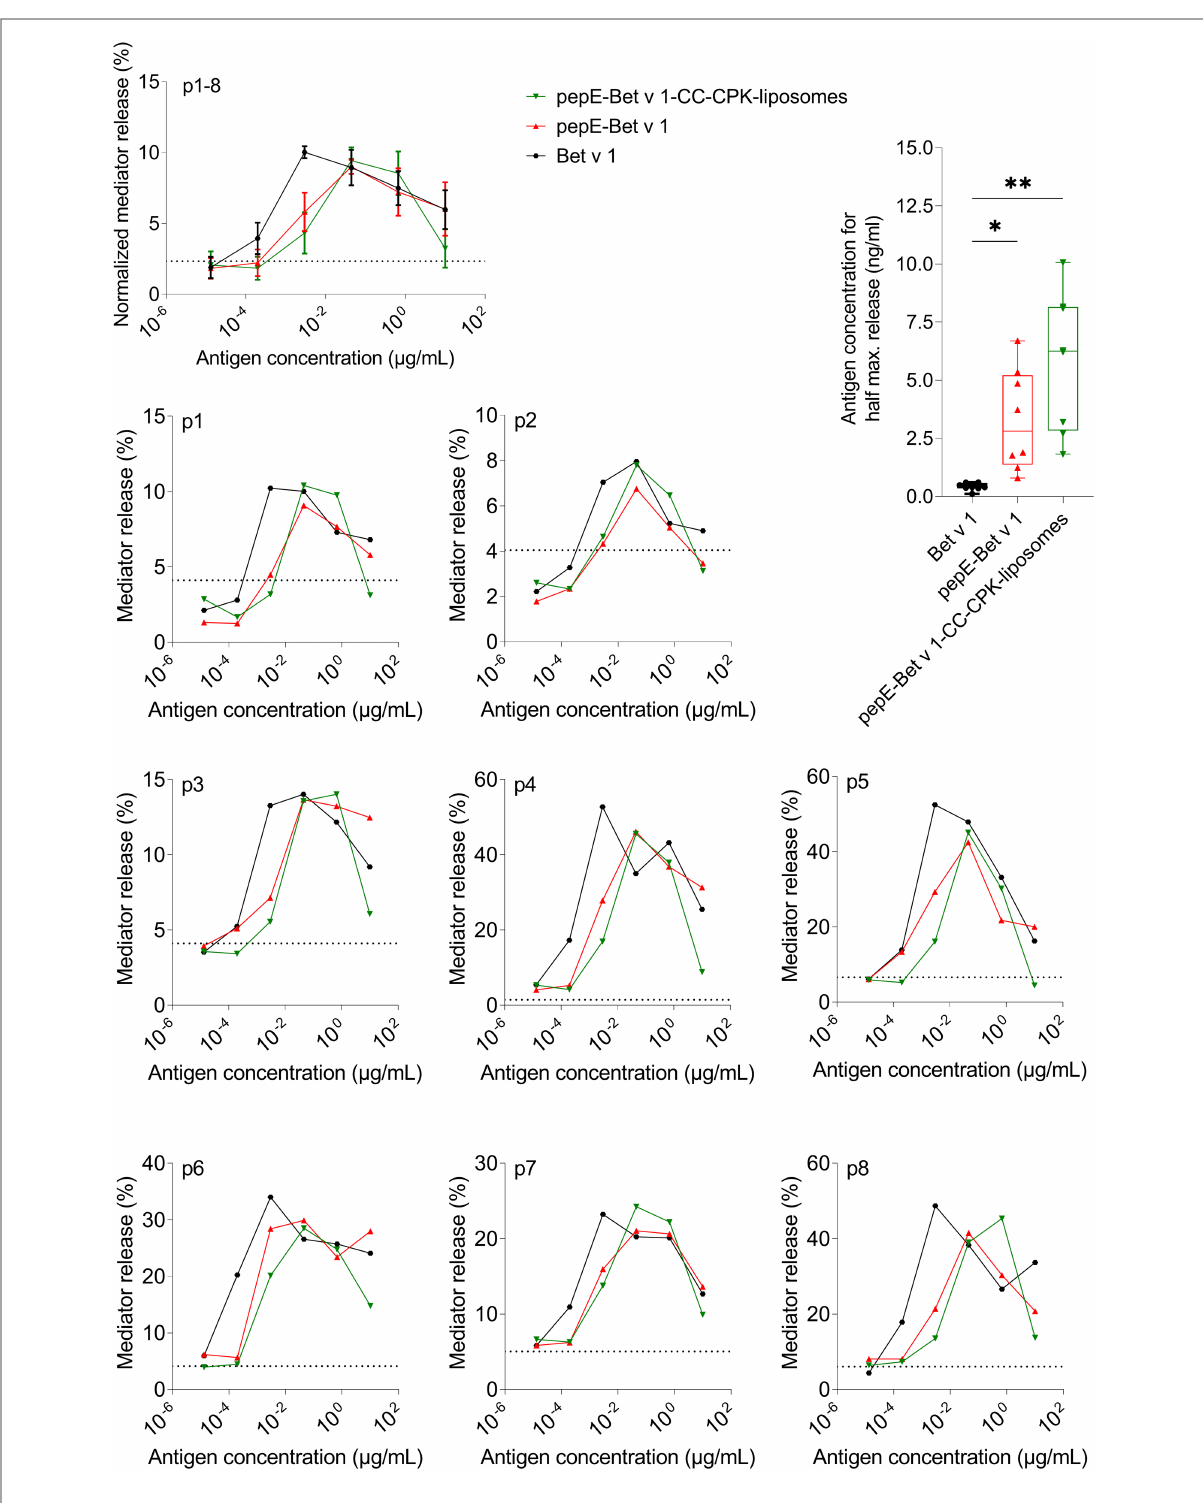
FIGURE 3 Allergenicity assessment by rat basophil leukemia cell assay. Rat basophils loaded with IgE from serum of Bet v 1-sensitized subjects were stimulated with different allergen formulations. Allergenicity was quanti fi ed by determining the concentration needed for half maximum mediator release. Differences between the groups were analyzed with a one-way ANOVA followed by Tukey ’ s multiple comparisons test. Dotted line represents spontaneous mediator release by non-stimulated cells. The averaged, normalized curves of 8 patient sera (p1-8) as well as the patient speci fi c mediator release curves showed a shift to the right of all pepE-Bet v 1 containing samples, indicating hypo-allergenicity. *= p <0.05, **= p